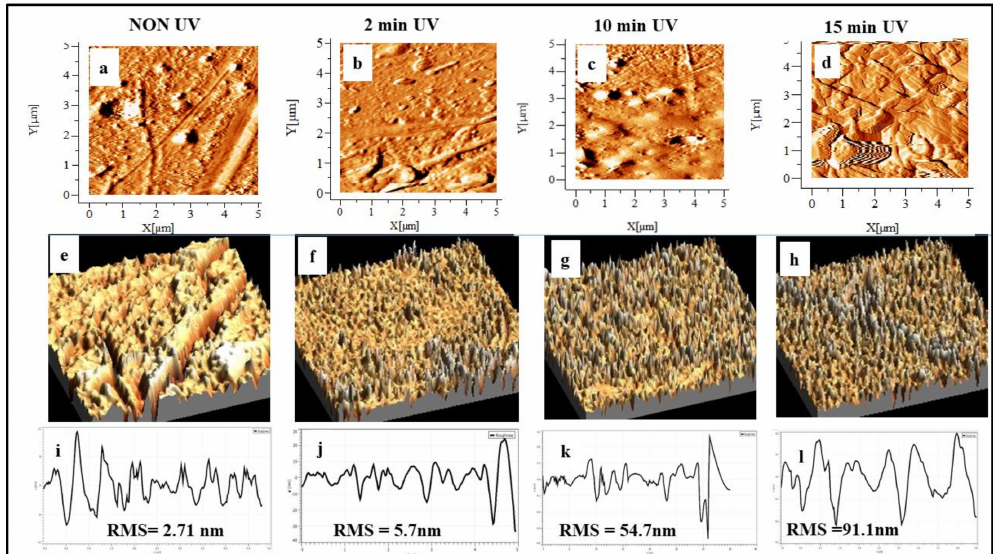
Figure 10. AFM images of PLA tubular scaffolds before and after UV